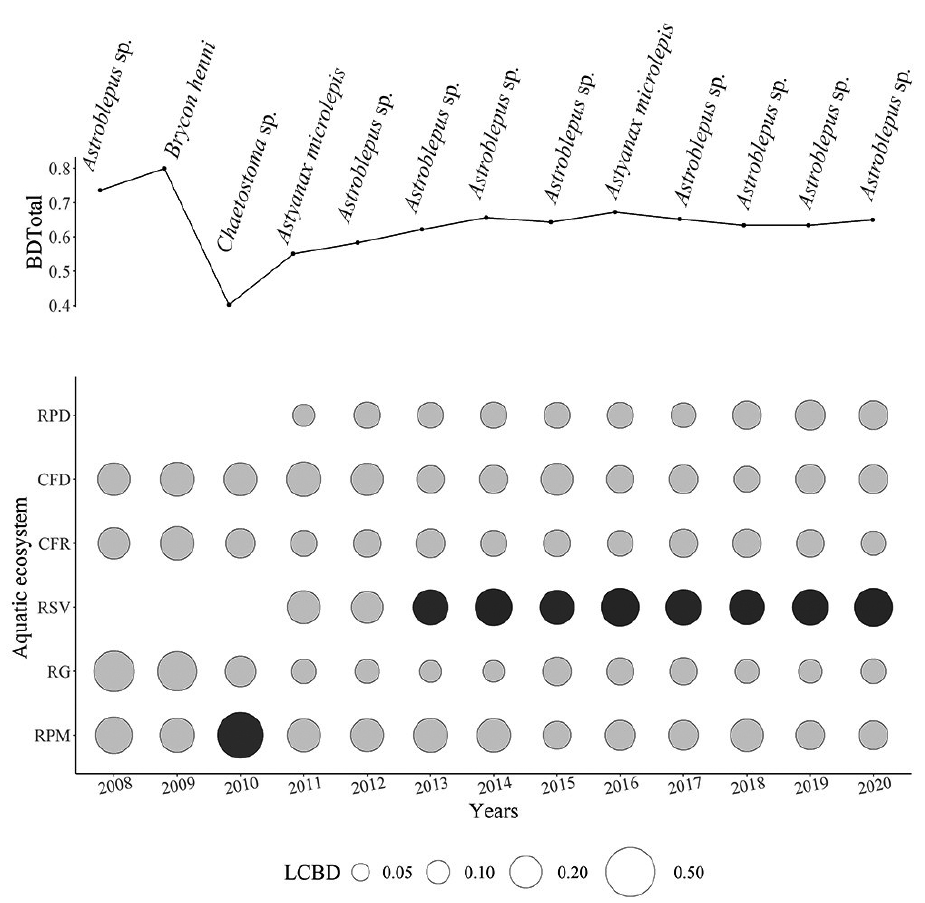
FIGURE 6 | Total variance in beta diversity (BDTotal) in each year and first Species Contributions to Beta-Diversity (SCBD) by year. Local contribution to beta-diversity (LCBD) per aquatic environment and year (black circles represents significant values p <